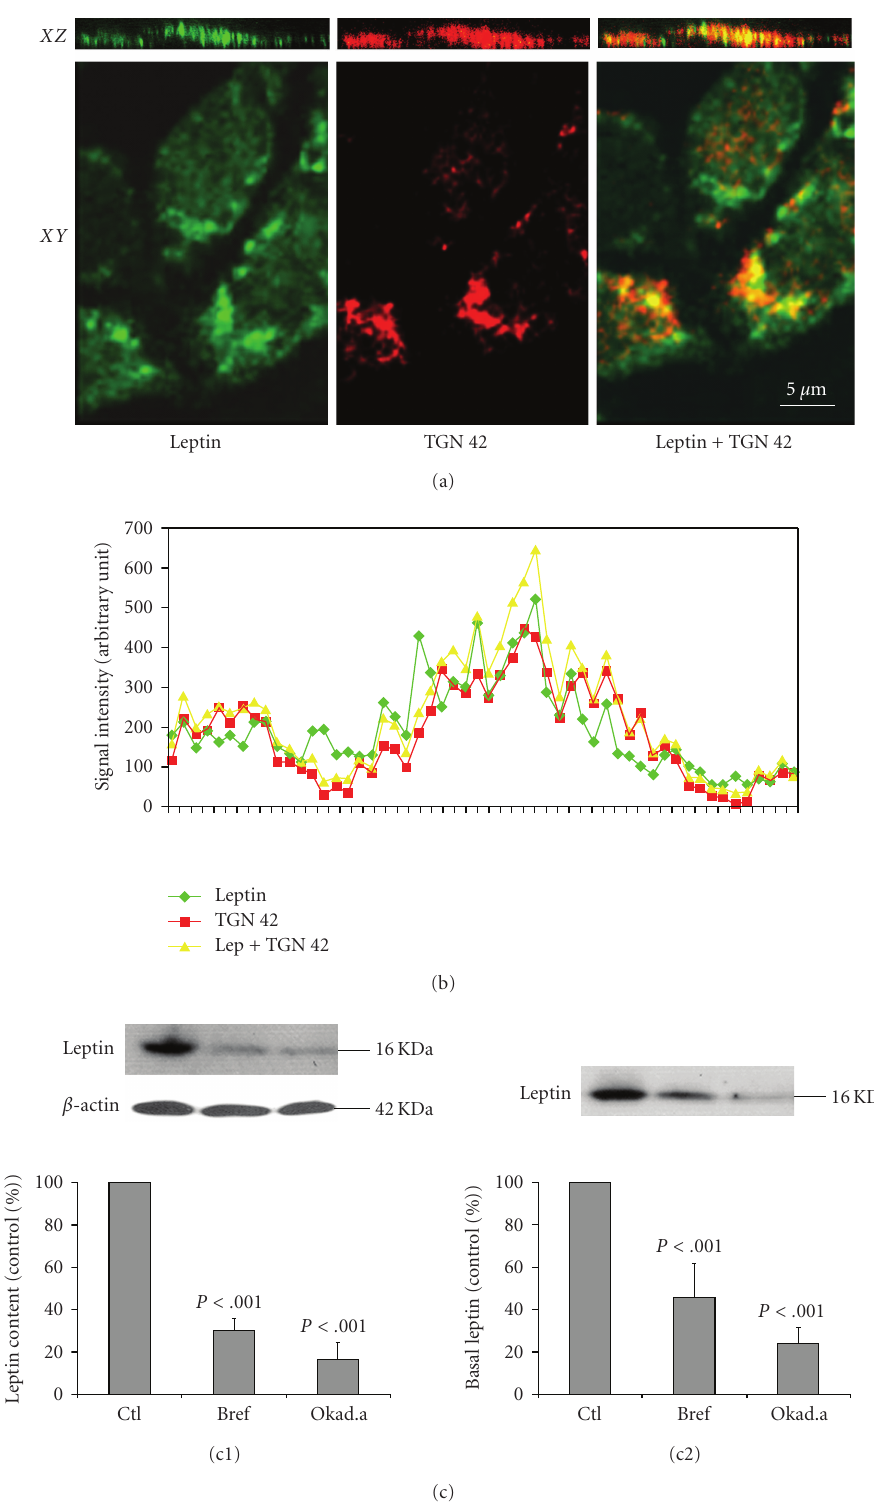
Figure 7: Involvement of the Golgi apparatus in leptin transcytosis . Caco-2 cells were exposed to leptin-FITC for 30 minutes. (a) By confocal microscopy, leptin (green fluorescence) and TGN42, a marker of the Golgi apparatus (red fluorescence), appear colocalized (yellow staining) in spots ( XZ plane) or as crescent-shaped structures close to the nuclei ( XY plane). (b) Quantification of signal for leptin and TGN42 in XZ view confirmed colocalization. (c) Inhibitors of Golgi tra ffi cking, brefeldin A (Bref) (10 μ g/mL), and okadaic acid (Okad.a) (0.5 μ M) were added to the cell medium for 30 minutes prior adding leptin. Cellular content (c1) and concentrations of leptin in the basal medium (c2) were decreased by the two agents. Results are expressed as mean values ± s.e.m ( n =